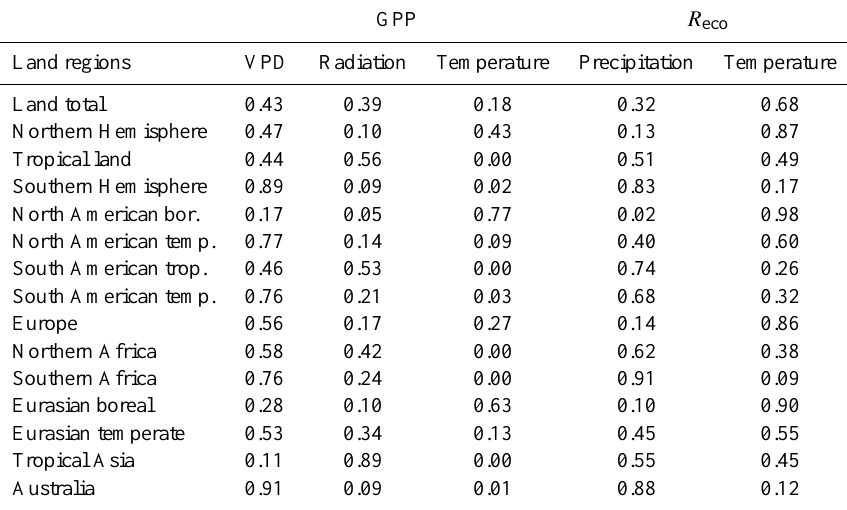
Table 3. Climatic contributions to the interannual variability of GPP and R eco over different land regions. The contribution was calculated using Eq. (15) and 16.